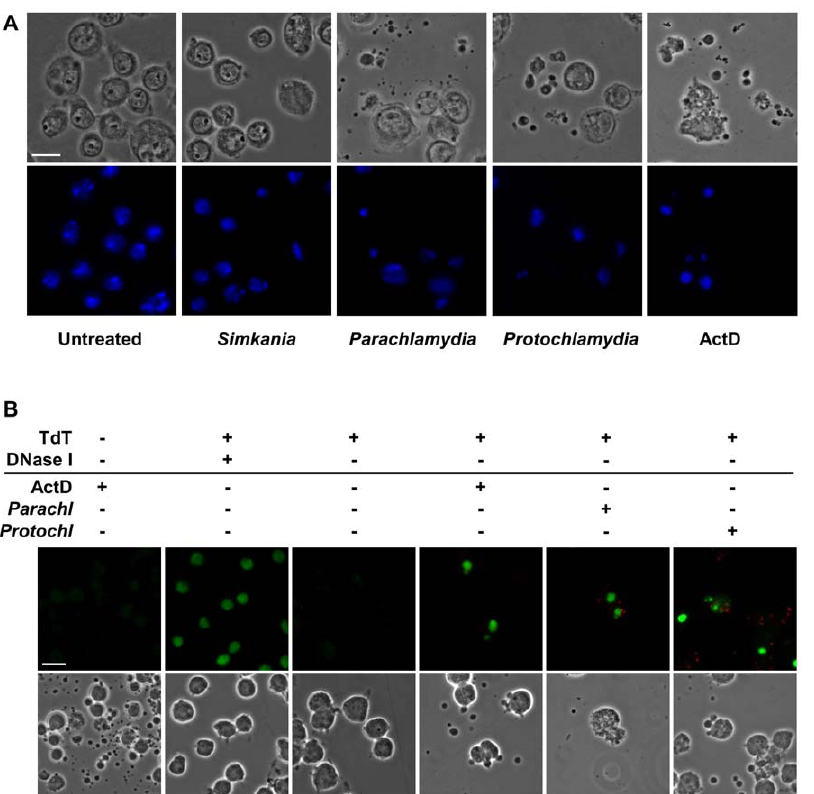
Figure 3. Parachlamydiaceae -induced cell death in S2 cells is accompanied by apoptosis-like morphological and nuclear changes and DNA fragmentation. Panel (A) illustrates morphological and nuclear changes that were observed in S2 cells in response to infection with Parachlamydiaceae , but not Simkania . Insect cells were infected with S. negevensis , Pa. acanthamoebae , or P. amoebophila (MOI 2.5). At 7 h p.i. DNA was stained with DAPI (blue). Untreated cells and cells treated with the apoptosis inducer ActD (7 h) are shown for comparison. The bar corresponds to 10 m m. In (B) the detection of DNA fragmentation by TUNEL staining in S2 cells infected with Parachlamydiaceae is shown. S2 cells were either left untreated, incubated with ActD (10 h), or infected with Pa. acanthamoebae or P. amoebophila (MOI 2.5, 10 h). Bacteria were detected by immunostaining using antibodies raised against purified bacteria (red). TUNEL-positive nuclei are shown in green. Two additional controls were included, a negative control where TdT was omitted from the TUNEL reaction mixture and a positive control where cells were preincubated with DNase I to experimentally introduce DNA double strand breaks in all (also non-apoptotic) cells. Note that apart from this control, TUNEL-positive cells typically display other characteristic features of apoptotic cells, such as condensed and fragmented nuclei and formation of apoptotic bodies. After infection, TUNEL-positive cells were also frequently associated with bacteria. The bar indicates 10 m m.